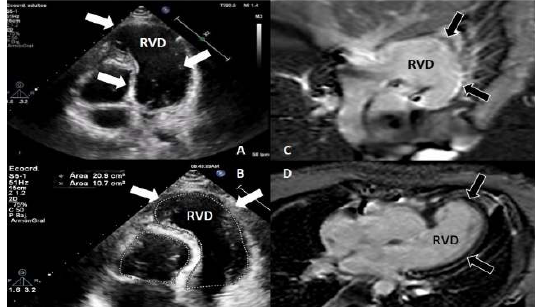
Figure 1: Echocardiographic images in 4 chambers projection (A, B) and Magnetic Resonance (B, C) that show a Right Ventricle Dliated (RVD); absence of myocardial tissue in apex, thinning and fibrosis in lateral wall